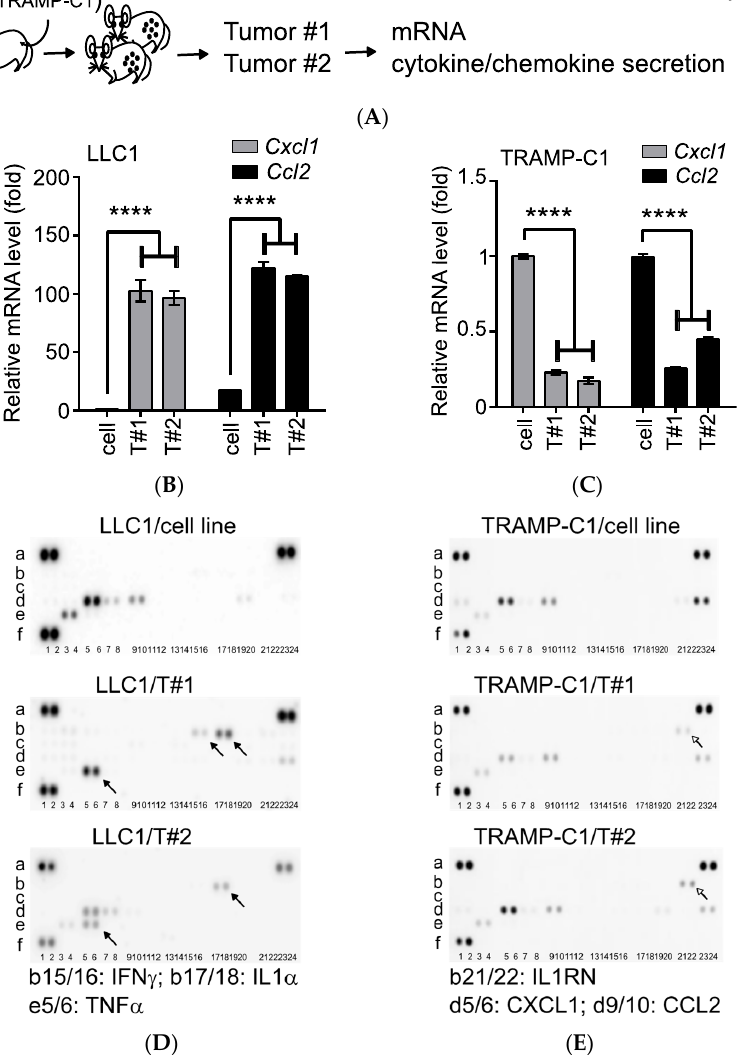
Figure 1. Transgenic adenocarcinoma of the mouse prostate (TRAMP)-C1-derived tumors show tumor- type-specific anti-inflammatory environments. ( A ) The outline of analyzing the tumor microenvironment. Following a subcutaneous injection, tumor tissues (Tumor#1 (T#1) and T#2) were analyzed for transcription expressions of selected genes (mRNA) or processed to single-cell suspensions without red blood cells to detect the secreted factors in the conditioned medium (cytokine/chemokine secretions). ( B ) Comparison of mRNA levels of proinflammatory chemokines (Cxcl1 and Ccl2 ) between the LLC1 cell line and its derived tumor samples (T#1 and T#2). ( C ) Comparison of the mRNA levels of the proinflammatory chemokines (Cxcl1 and Ccl2 ) between the TRAMP-C1 cell line and its derived tumor samples (T#1 and T#2). RT-qPCR measurements were derived from three technical replicates, and the results are presented as the mean ± SD. Student’s t -test. **** p < 0.0001. ( D ) Comparison of the cytokine/chemokine profiles of the LLC1 cell line and its derived tumors (T#1 and T#2). Differentially secreted factors are labeled with black arrows. ( E ) Comparison of the cytokine/chemokine profiles of the TRAMP-C1 cell line and its derived tumors (T#1 and T#2). Secretion of the interleukin-1 receptor antagonist (IL1RN) was increased in the tumors (white arrows).